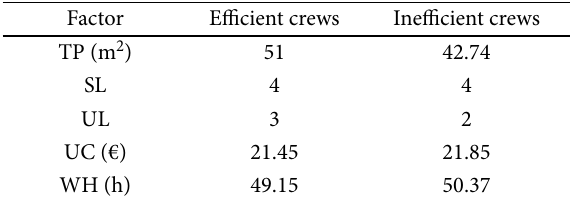
Table 4. Comparison of efficient and inefficient plastering crews Factor Efficient